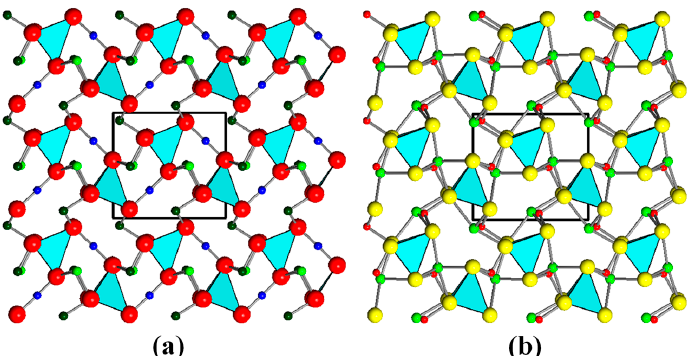
Figure 4. The crystal structure of quijarroite ( a ) compared to that of bournonite ( b ) [14], both drawn down [001]. In quijarroite, dark blue spheres indicate the linearly coordinated Cu/Hg atoms, whereas light blue tetrahedra refer to the partially occupied Cu position (Cu 0.75 (cid:3) 0.25 ). Light, dark green and red spheres refer to Bi, Pb and Se, respectively. In bournonite, light blue tetrahedra refer to Cu, whereas green, red and yellow spheres refer to Pb, As and S, respectively.